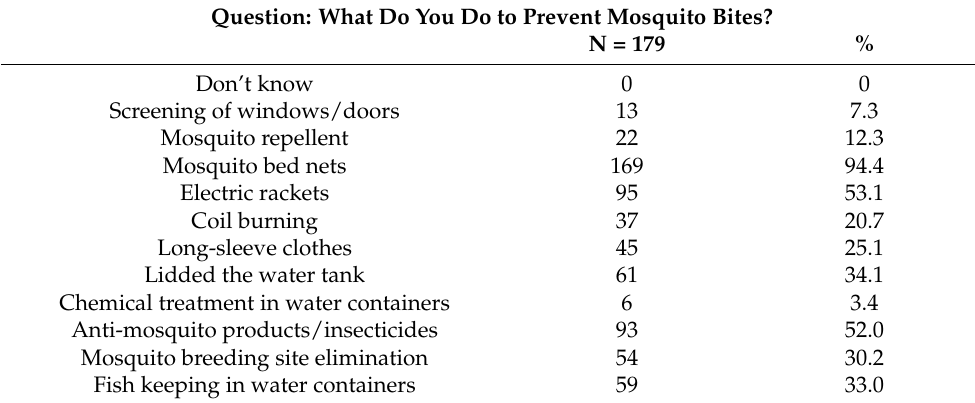
Table 3. Practices of pig farmers about mosquito-borne